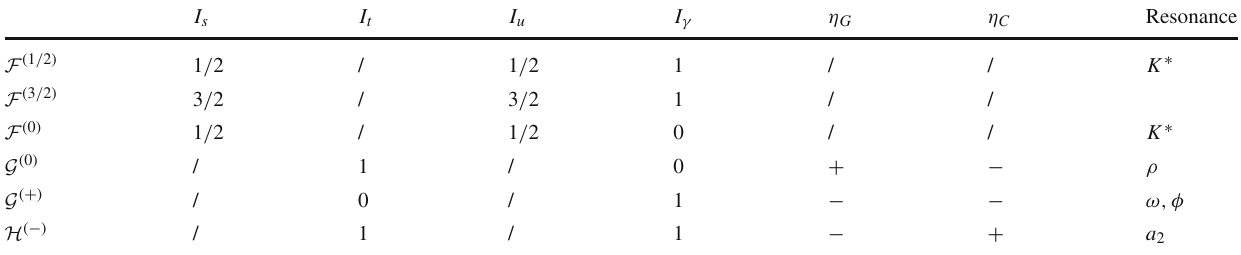
Table 1 Quantum numbers of the six single-variable amplitudes. The isospin in the s -, t -, and u -channels is denoted by I s , I t , and I u , respec- tively. I γ refers totheisospin ofthe photon. The C and G eigenvalues of